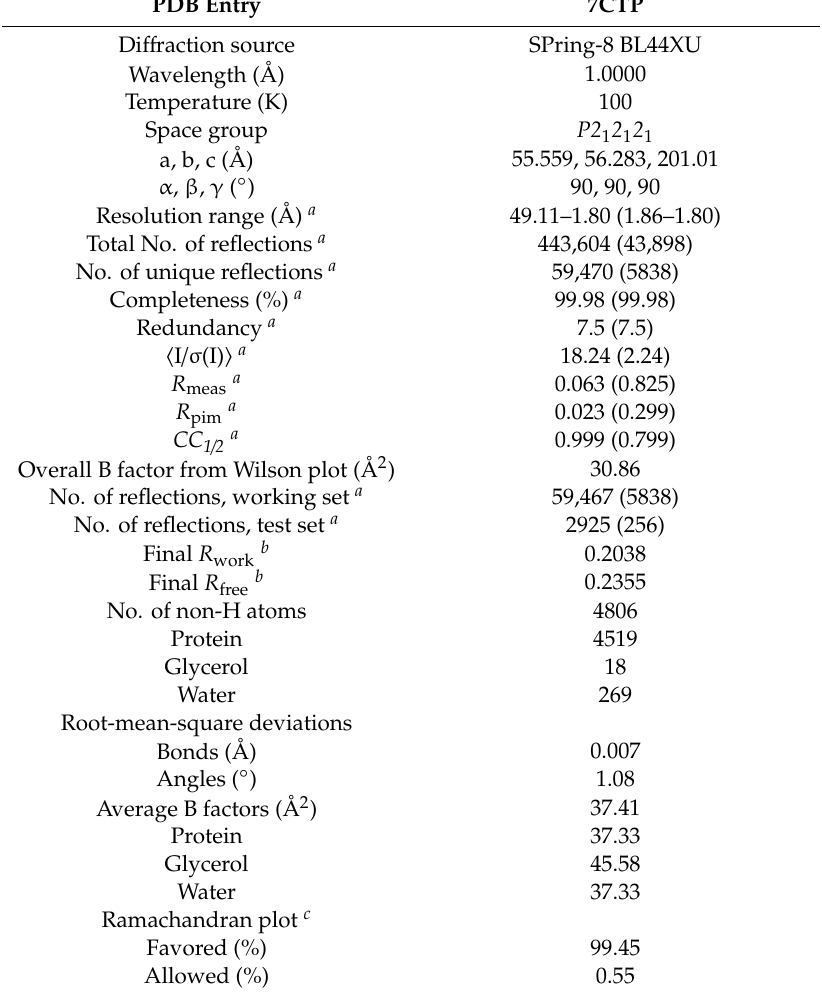
Table 1. Data collection and refinement statistics for MINERVA ∆ C crystal